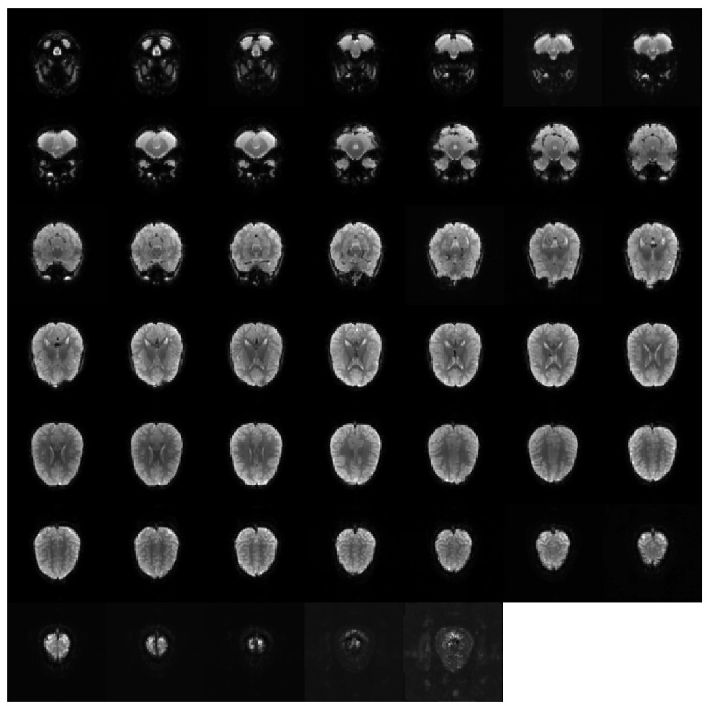
Figure 6. Display of custom template-instance slices of subjects of ABIDE50795.